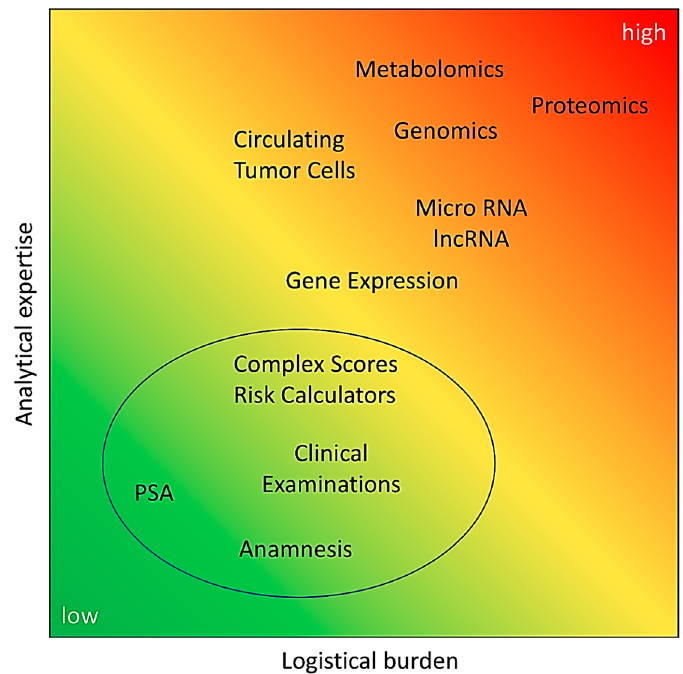
Figure 1. Feasibility of liquid biomarker-based diagnostics. The financial burden is coded by colour (green = low, yellow = medium, red = high); at present, advanced analytical methods come with higher high technical requirements and the need for very high analytical expertise; generally, gene expression, genomics, proteomics, and metabolomics require specialized analysis laboratories. In most cases, e.g., for untargeted analyses, standards have not been defined yet; this accelerates the threshold for comprehensive establishment in the clinical routine. For instance, proteomic analyses are still expensive, require high analytical expertise, and are not comprehensively available. On the other hand, proteomic analyses are fairly good and standardized. Comparing metabolic analyses, they require higher expertise than the more standardized proteomics, but are less expensive. The logistical burden grows with the complexity of the clinical and analytical requirements; circle indicates currently well established methods of PCa diagnostics.